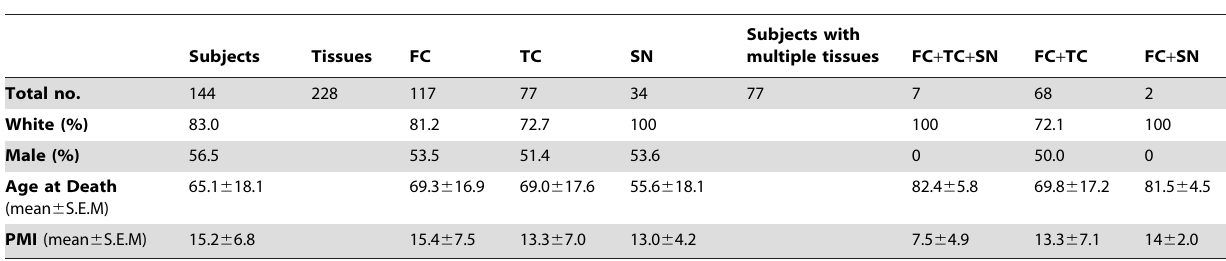
Table 1. Demographic description of the brain samples.